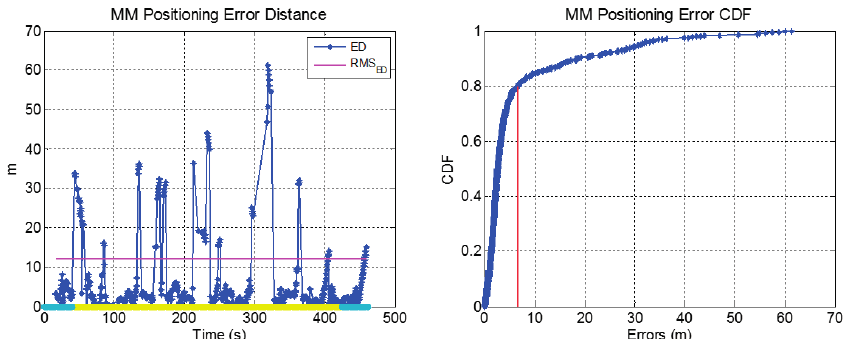
Figure 11. MM position errors at